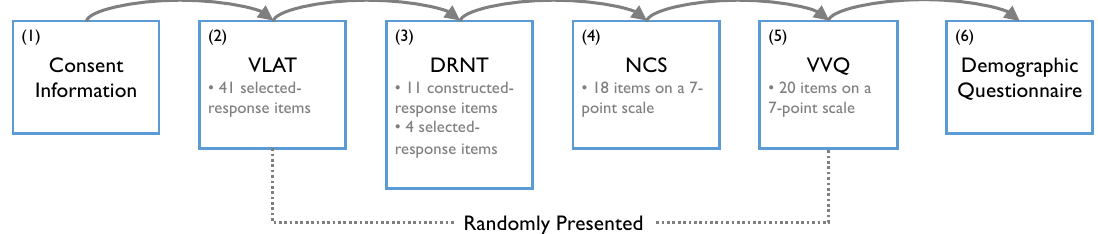
Figure 2. The experiment procedure that consists of six stages. Stages 2, 3, 4, and 5 were randomly presented to the